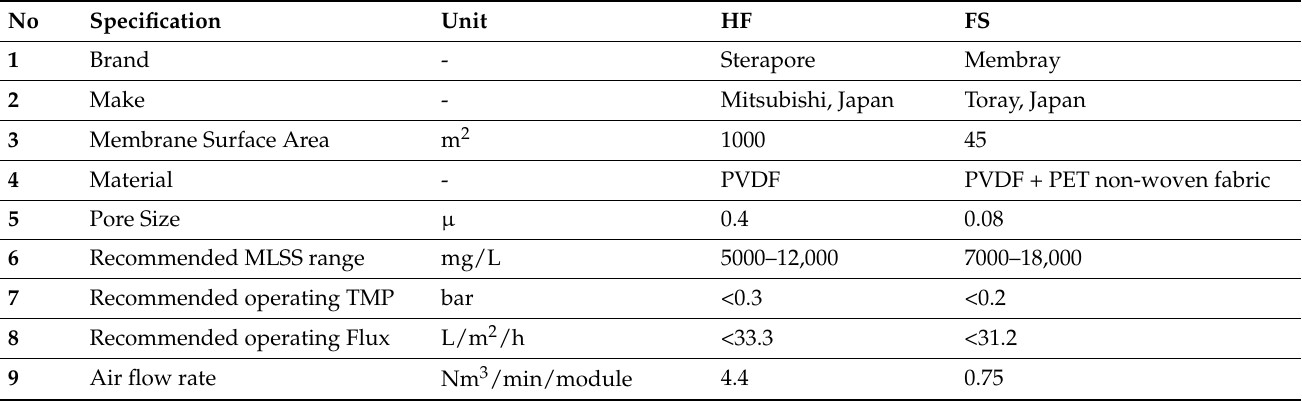
Table 3. MBR module